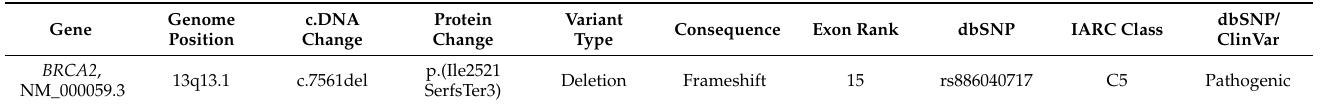
Table 1. BRCA2 germline pathogenic variant identified in patients and families. IARC, Interna- tional Agency for Research of Cancer; dbSNP/ClinVar, variant classification according to the Single Nucleotide Polymorphism database (dbSNP) and Clinical Variant (ClinVar).